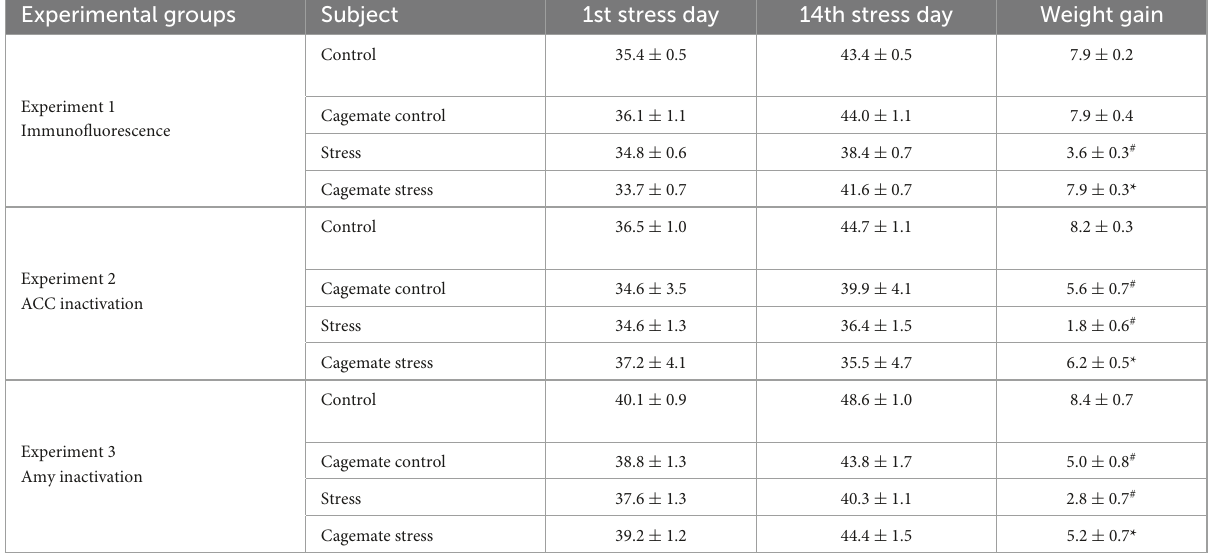
TABLE 1 Body weight gain during 14 days of restraint stress.